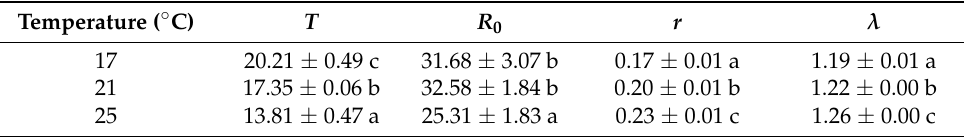
Table 2. Life table parameters of Uroleucon formosanum under different